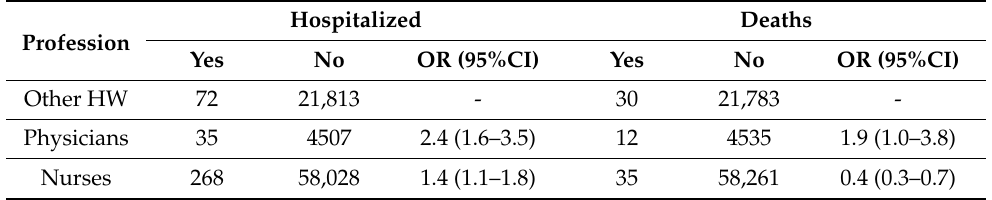
With physicians and nurses, the odds for a claim concerning hospitalization increased compared to other HW (OR 2.4 and 1.4) (Table 4). For deaths, the odds increased for physi- cians (OR 1.9) and were lower for nurses (OR 0.4). The effect was statistically significant for nurses but only of borderline significance for physicians (95% CI 1.0–3.8, p = 0.06). Table 4. Workers’ compensation claims concerning hospitalization and death with odds ratios (OR) and confidence interval (CI) broken down by nurses, physicians and other health workers